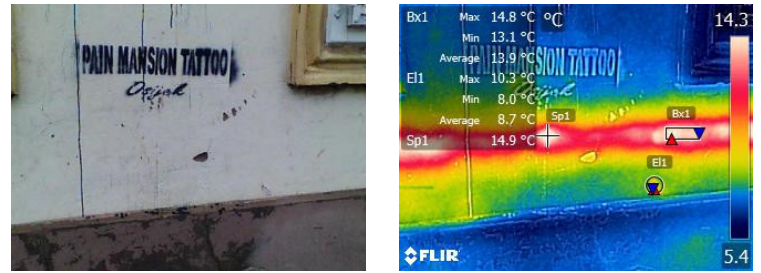
Figure 21. Influence of damage to the thermal pattern.